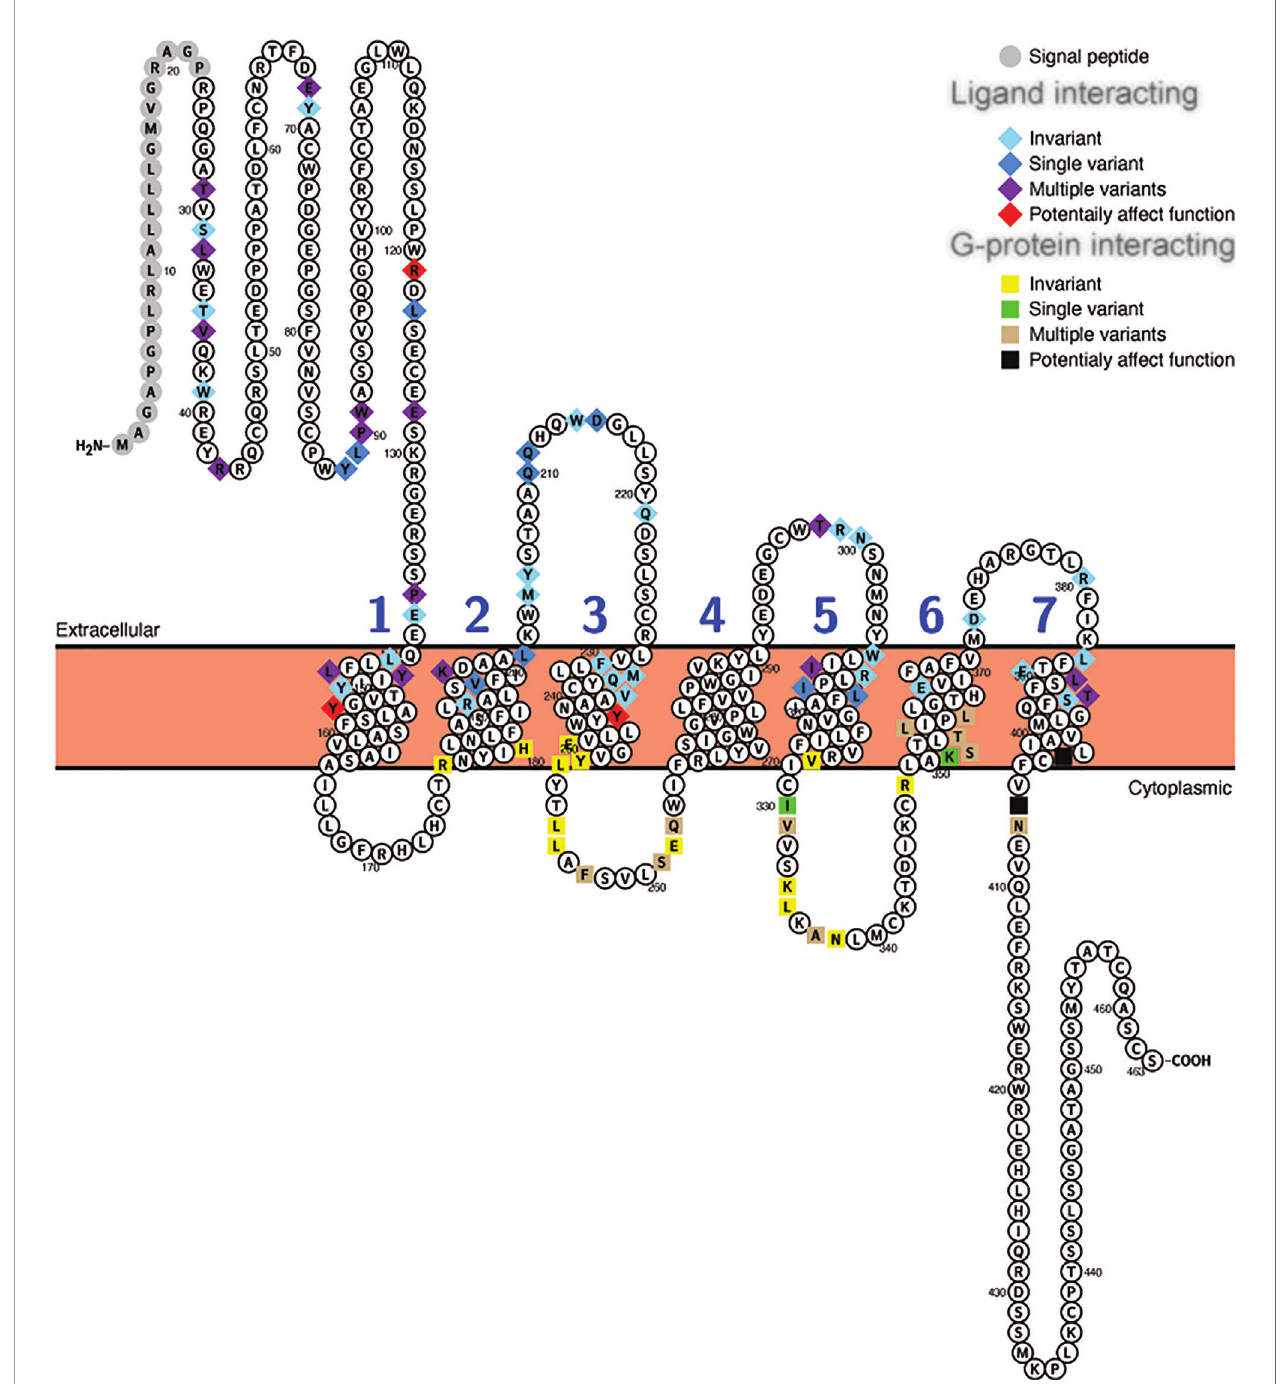
FIGURE 4 | Variability in ligand and G-protein interacting sites in mammalian GLP-1 receptors (Glp1r). Snake plot of the Gcgr protein sequences (Uniprot accession: GLP1R_HUMAN) generated with Protter (wlab.ethz.ch/protter/start/) (71). Extracellular regions are shown at the top, cytoplasmic regions at the bottom, and transmembrane domains between the two lines. Signal peptides and transmembrane domains are extracted from the Uniprot accession fi les for the proteins by Protter. Signal peptide resides are shown in gray. The transmembrane domains are numbered (1-7). Ligand interacting residues are shown as diamonds and G- protein interacting sites as squares. Variability in the ligand and G-protein interacting residues in the sequences from 78 mammalian species are displayed in different colors with light blue diamonds and yellow squares being invariant, dark blue diamonds and green squares only have one species varying, purple diamonds and tan squares representing sites that either vary in multiple species and/or have multiple amino acid states, while red diamonds and black squares identify sites that have a substitution that was predicted to “ Affect function ” by SIFT (67) and be “ Deleterious ” by PROVEAN (68).